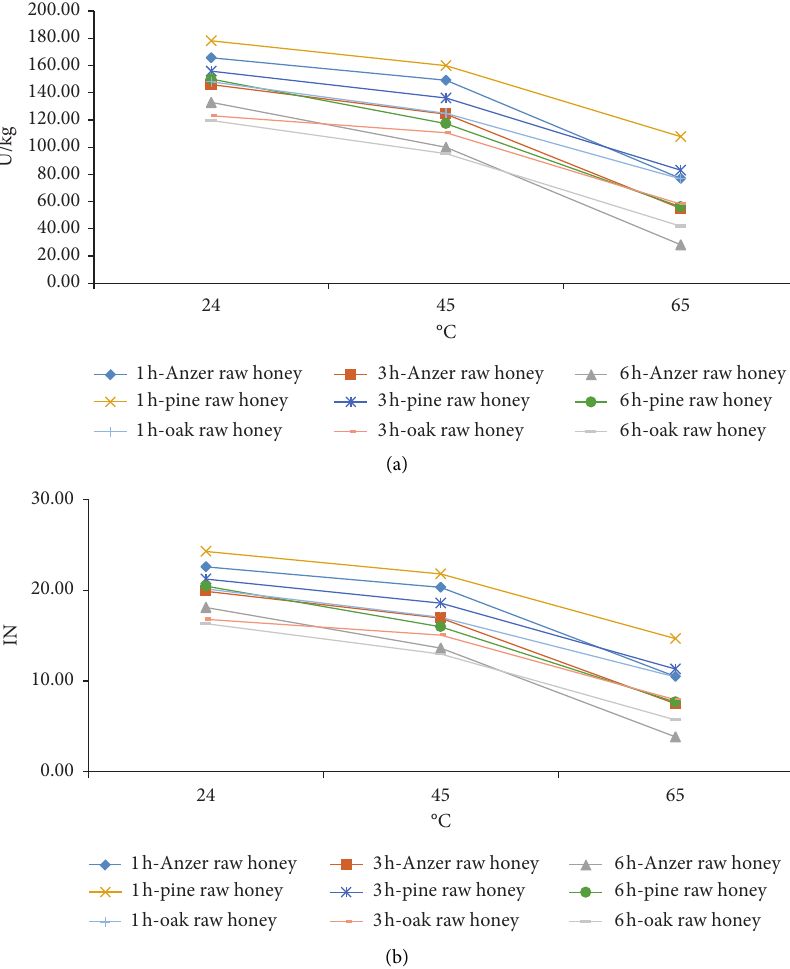
Figure 1: The invertase activity changing under the timing and heating conditions in terms of (a) U/kg and (b)